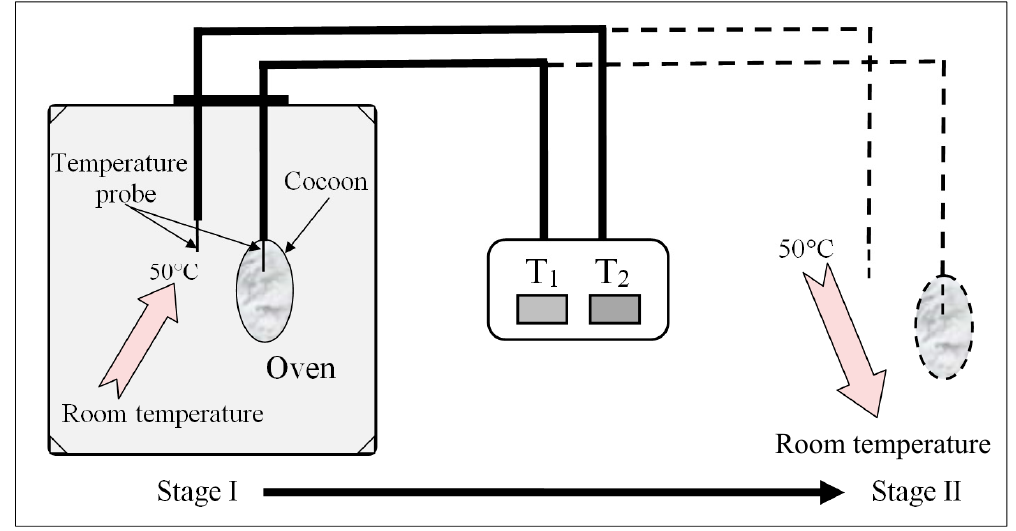
Figure 3. Schematic diagram of self-made cocoon temperature insulation performance test device and its test